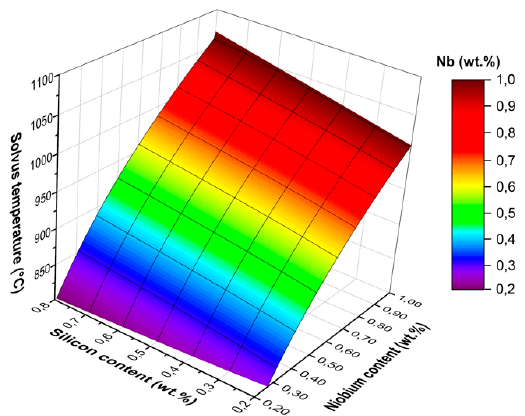
Figure 2. The simulated solvus temperature of η -phase as a function of Si and Nb contents (wt.%) in 0.02C-0.02N-21Cr-0.32Mn-0.2Ti base composition. 0.02C-0.02N-21Cr-0.32Mn-0.2Ti base